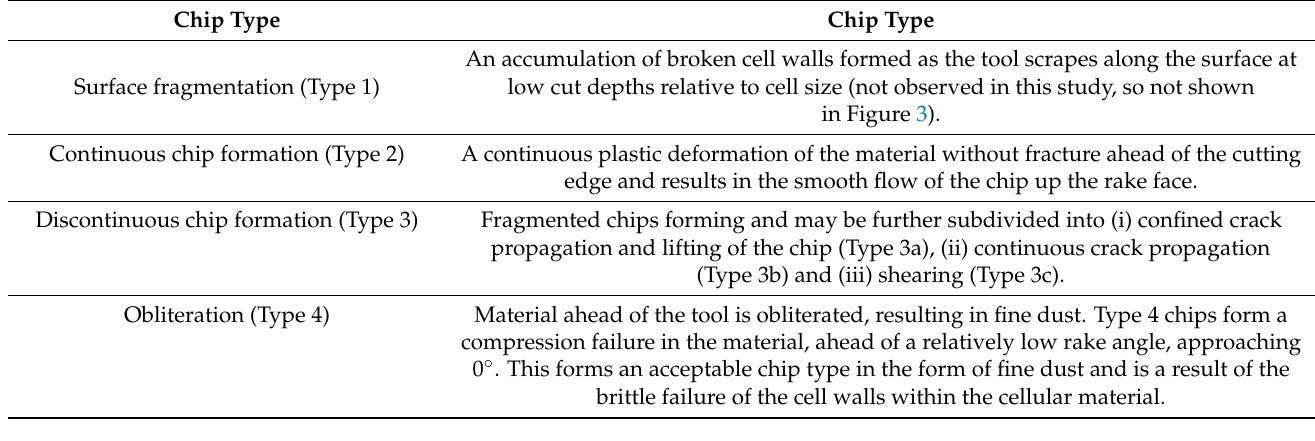
Table 4. Categorisation of chip formation based on study by Malak and Anderson (2005).